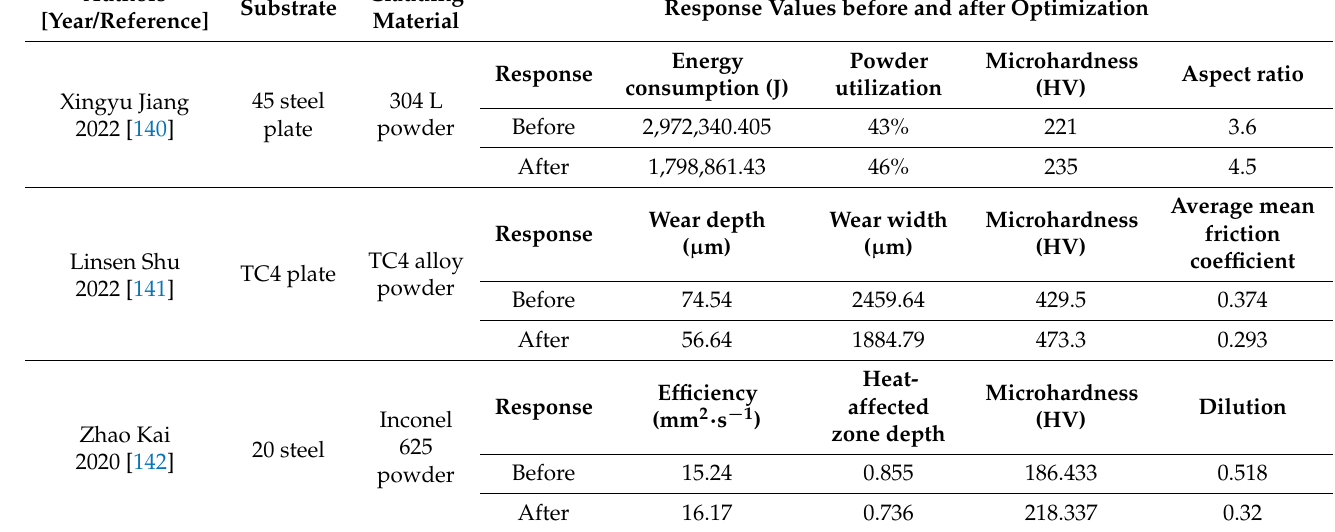
Table 6. Comparison of response values before and after NSGA-II